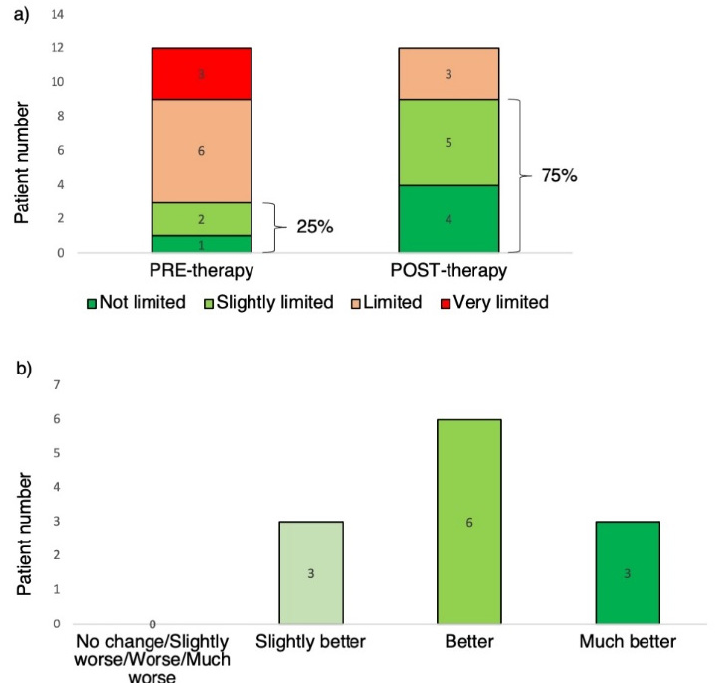
Figure 3. ( a ) Global Rating of Activity Limitation before and after mepolizumab therapy; ( b ) Global Impression of Change in Activity Limitation after mepolizumab therapy. Impression of Change in Activity Limitation after mepolizumab